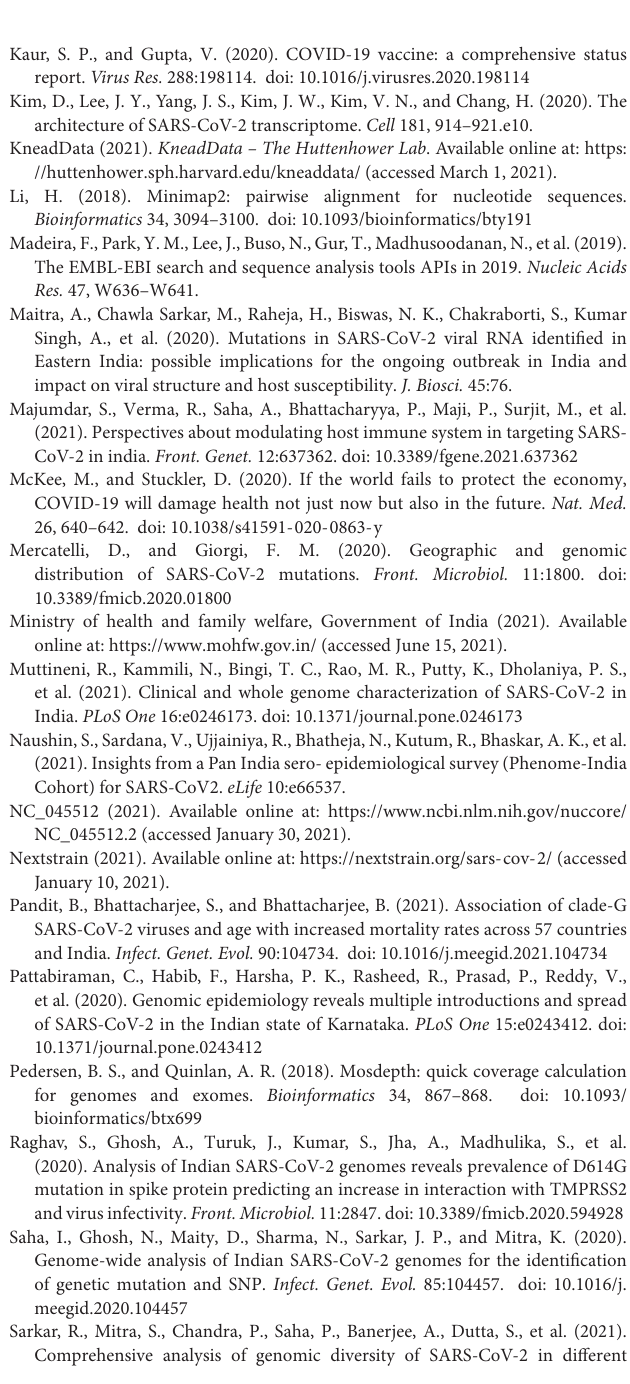
status of COVID-19 patients—deceased (D), symptomatic (S), mild (M), and asymptomatic (A), respectively—is shown for the most prevalent clades from India (A) , Europe (B) , and North America (C) , respectively. Supplementary Figure 7 | Association of specific co-mutation patterns with the status of the COVID-19 patients from Europe and North America. Frequencies of specific co-mutations are plotted with respect to the four status categories of COVID-19 patients: deceased, symptomatic, mild, and asymptomatic, respectively. (A) Data from Europe. (B) Data from North America. Clade-defining mutations are marked in corresponding